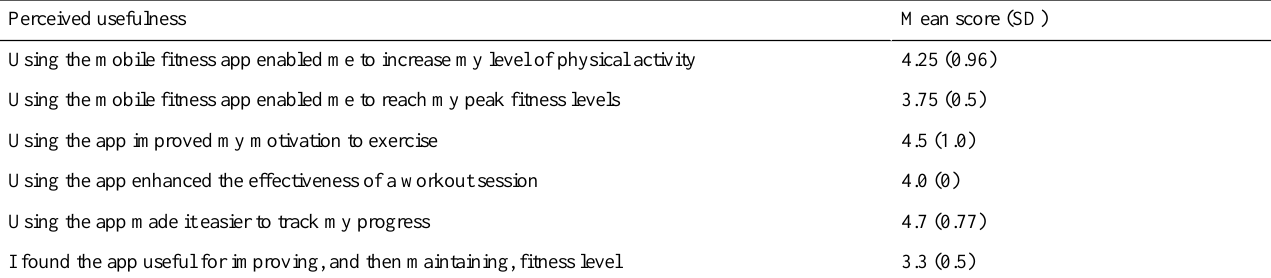
Table 5. Perceived usefulness of the app on a Likert scale ranging from 1 to 5 (higher scores indicate stronger agreement).